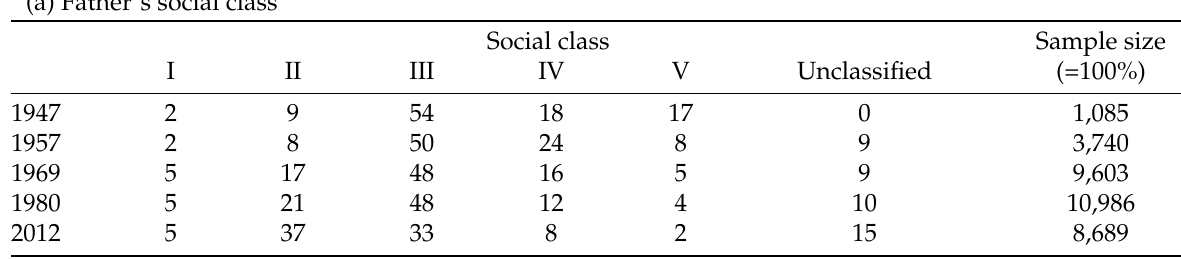
Table 1: Father’s social class and parental education, by year (a) Father’s social